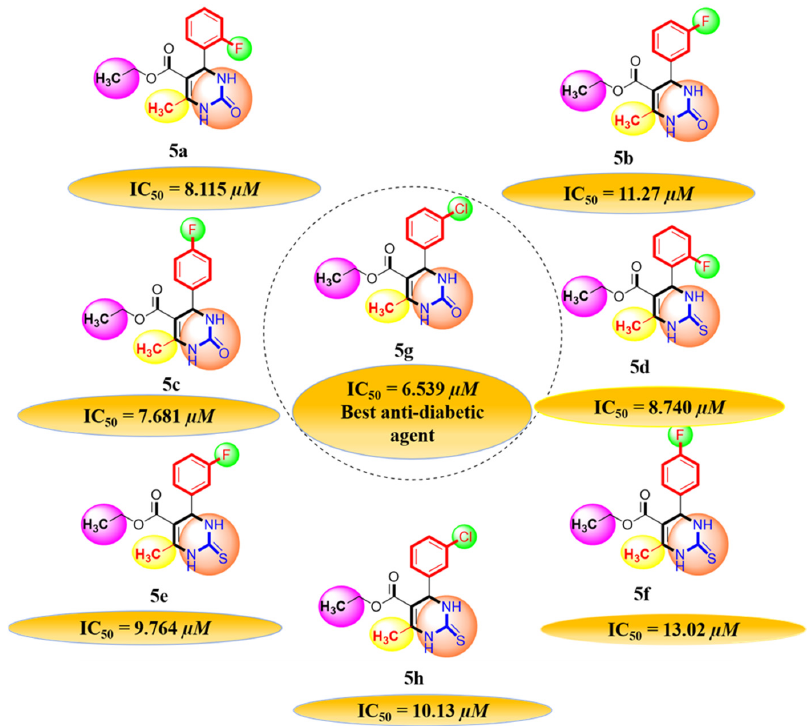
Figure 8. Diagrammatic relationship of target molecules ( 5a – h ) for their structure-activity relationship as anti-diabetic agents.